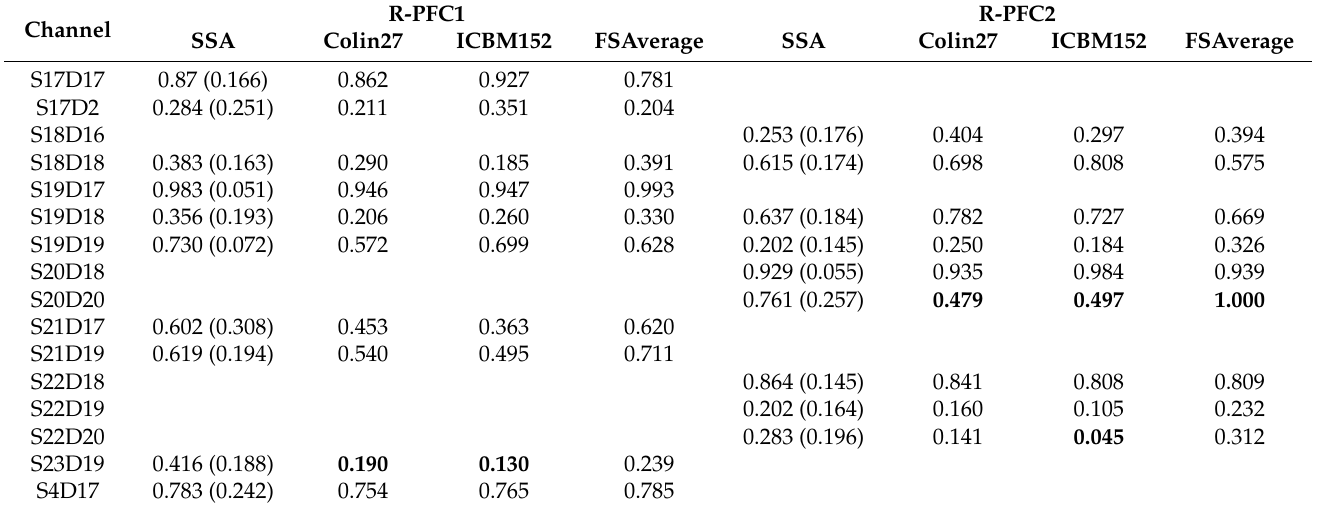
Table 12. Summary of A2Ch coefficients associated to selected right-hemisphere functional ROIs: dorsolateral (PFC1) and ventrolateral prefrontal cortex (PFC2). Results are reported for wavelength λ = 760 nm. Bold ABA values indicate channels presenting a 20% difference in A2Ch coefficients from the SSA